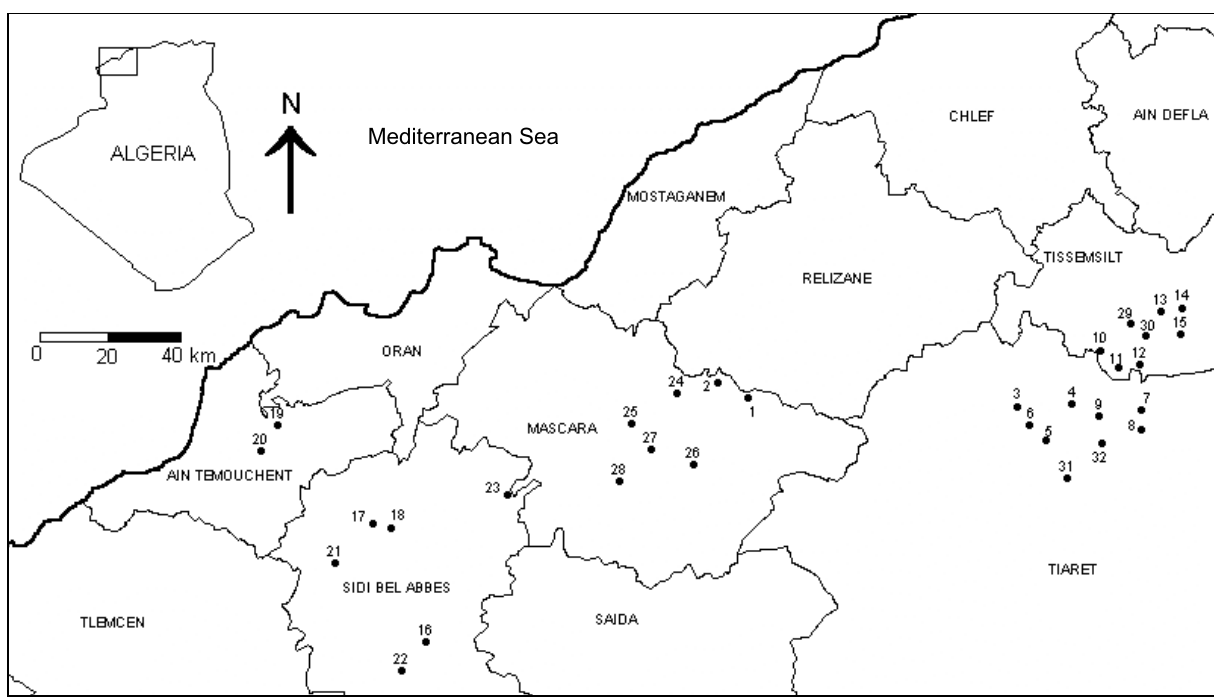
Fig. 1. Sites in Algeria from which isolates of Fusarium oxysporum f. sp. lentis were obtained. Numbers in the figure refer to numbers of isolates in Table